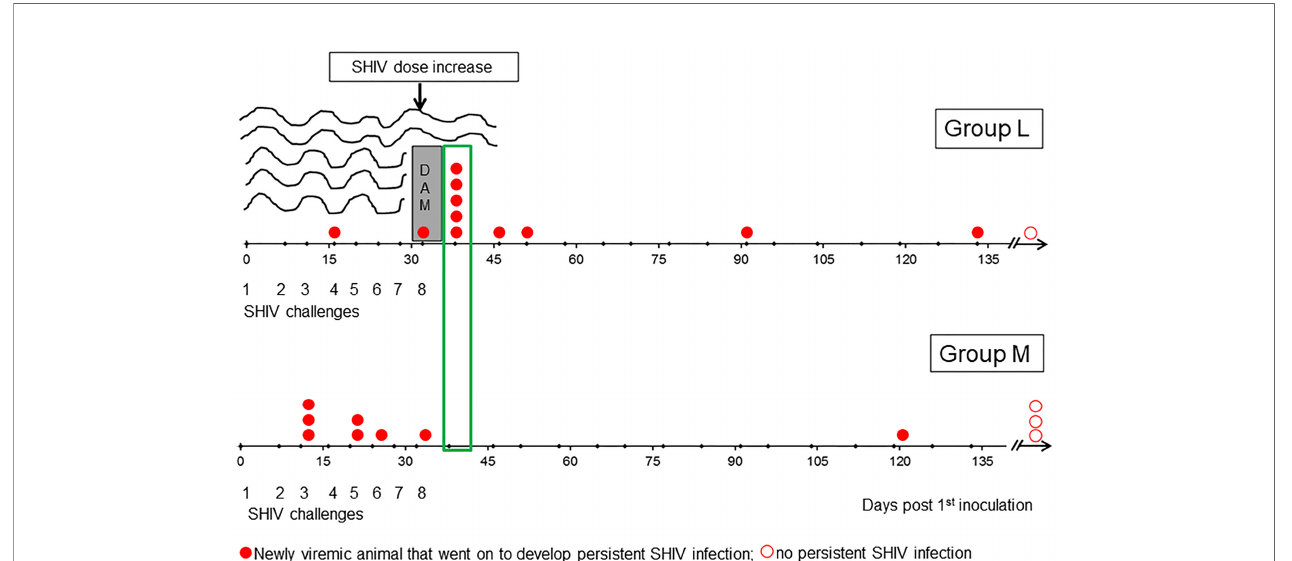
FIGURE 6 | Sudden loss of protection in Group L one week after challenge #8 when the virus dose was increased by 50%. On day 38, fi ve Group L animals lost protection (green box). We hypothesize that vaccine-induced mucosal antibodies were quite protective during Challenge Phase I, when only two breakthrough infections occurred. However, the additional antigen load in the 50% higher challenge virus dose overwhelmed vaccine protection in a large fraction of Group L animals immediately after the dose escalation – akin to fl ood water overtopping the dam, leading to fl ash fl oods and inundation. The implication of this “ dam ” hypothesis is that the immunogenicity of the virosome platform may need to be increased to boost both mucosal and systemic immune defenses for facing the virus doses administered during experimental intravaginal SHIV challenges in primate models estimated to exceed the HIV-1 inocula passed between infected men to their female partners (please see